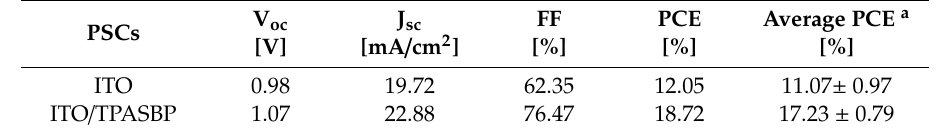
Table 1. The photovoltaic parameters of PSCs with perovskite film fabricated on ITO and ITO / TPASBP, respectively.